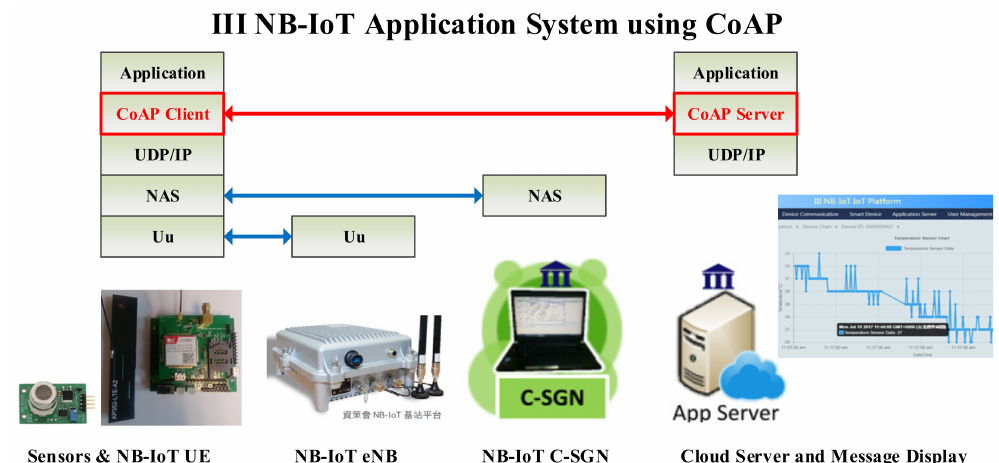
Figure 2. The III NB-IoT sensor system employs CoAP as the IoT communication